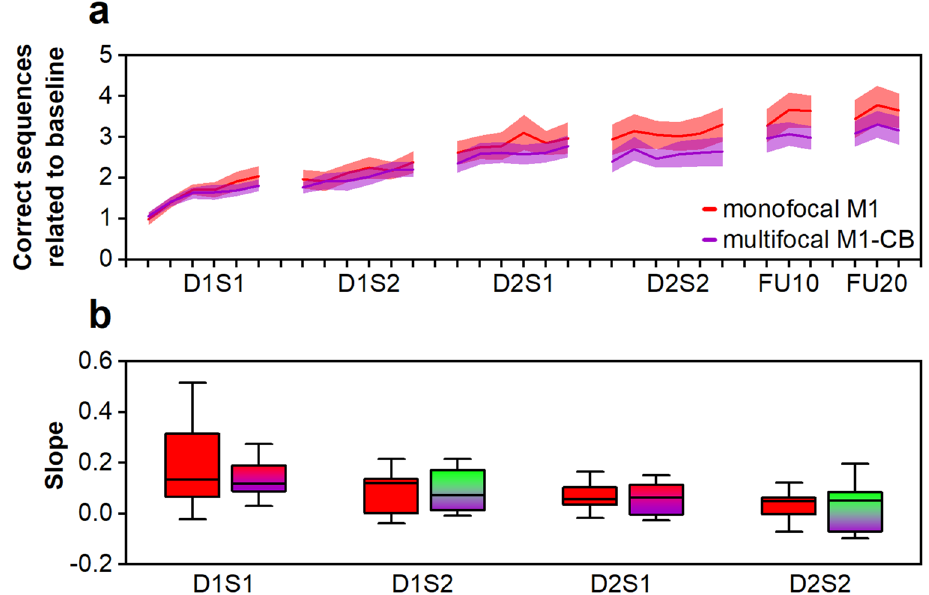
Figure 3. Sequential multifocal M1-CB stimulation. D1S1, day 1 session 1; D1S2, day 1 session 2; D2S1, day 2 session 1; D2S2, day 2 session 2; FU10, ca. 10 day follow-up; FU20, ca. 20 day follow-up. ( a ) Learning curves of the monofocal M1 (red) and the multifocal M1-CB group (violet). Margins of error correspond to standard error of the mean. ( b ) Comparison of slope of the learning trajectories during the training phase ordered per SESSION and CONDITION. Monofocal M1 group (red), multifocal M1-CB group at a session in which M1 stimulation was applied (gradient fill red-violet), multifocal M1-CB stimulation group at a session in which CB stimulation was applied (gradient fill green-violet). Box plots depict median (solid vertical line), box bounds (upper to lower quartile), whisker (range within 1.5 interquartile